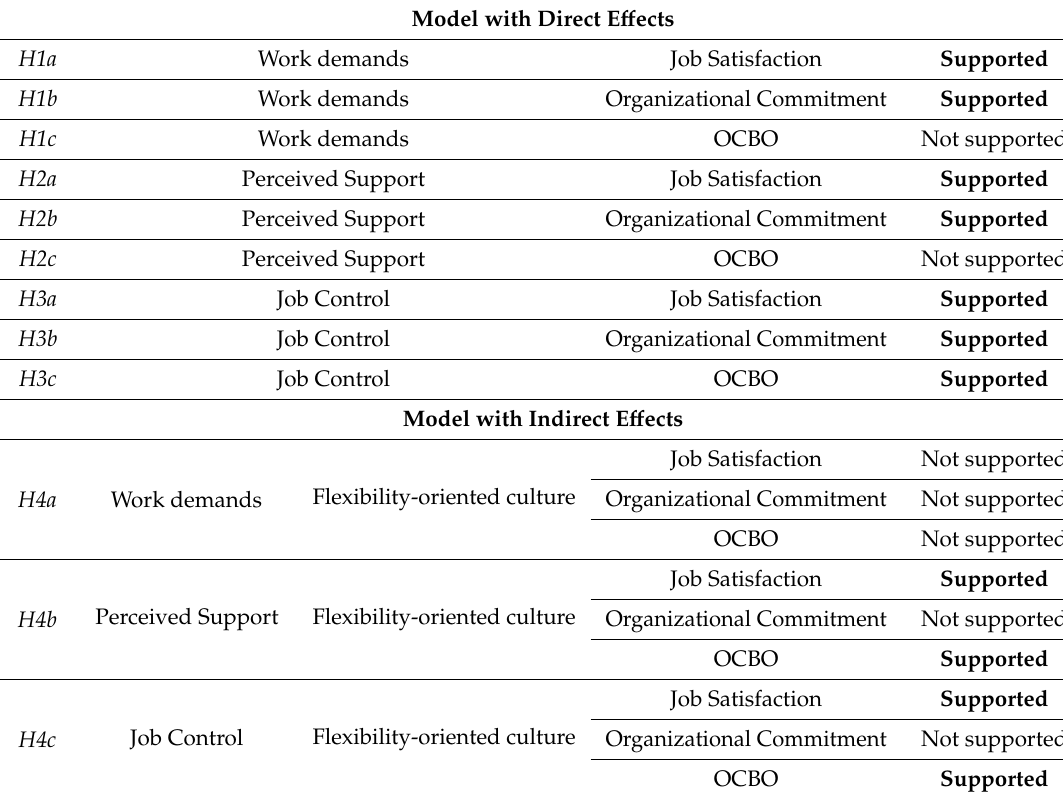
Table 6. Results of hypotheses testing ( N =